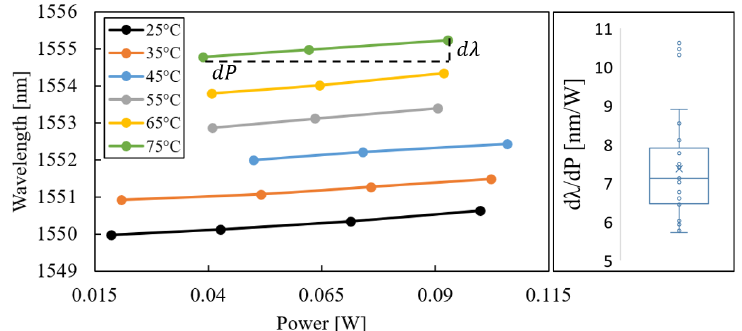
Figure 9. Laser wavelength as a function of thermal power and box plot of linear fit through all measured slopes of the five characterised